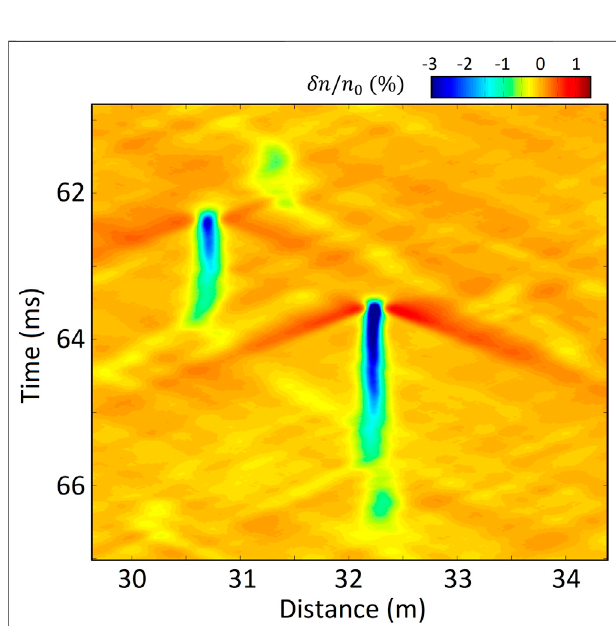
FIGURE 3 | Adapted from Akbari et al. (2016): Results from a one- dimensionalsimulationofLangmuirturbulenceinthenightsideFregionauroral plasma. Normalized ion density fl uctuations are shown in real space as a function of time. The feature located in the center of the plot illustrates a cycle of nucleation – collapse –